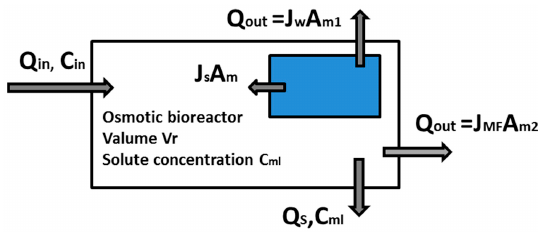
Figure 2. Mass balance in the OMBR ‐ MF system.